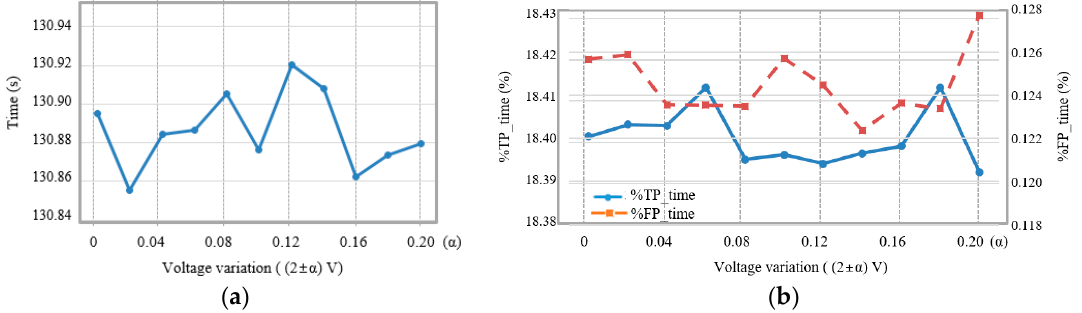
Figure 12. ( a ) Average detection time and ( b ) average % TP_time and % FP_time according to regular variations of the supply voltage.